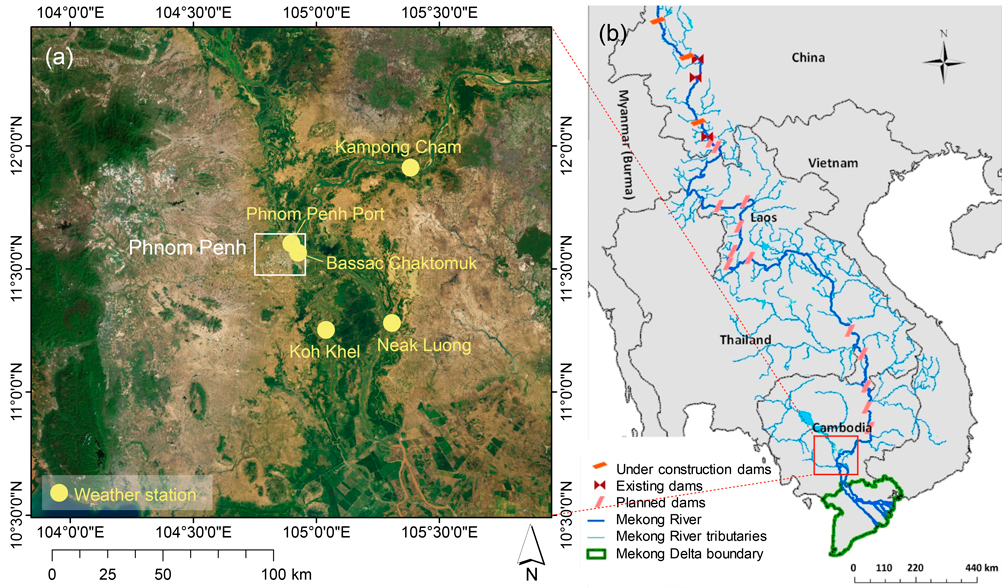
Figure 1. Location map of study area. ( a ) Satellite images of study area with locations of water station. Sources: Esri, DigitalGlobe, GeoEye, Earthstar Geographics, Centre National d’études Spatiales (CNES)/Airbus Defense and Security (DS), US Department of Agriculture (USDA), United States Geological Survey (USGS), AeroGRID, Institut Géographique National (IGN), and the GIS user community. ( b ) Location of study area with the Mekong River basin.